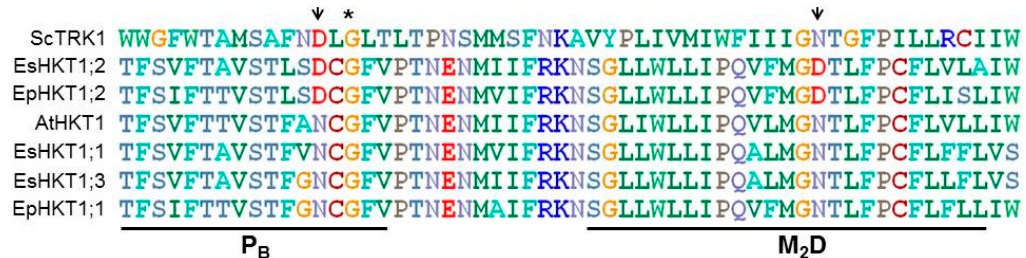
Figure 2. Sequence comparison of HKT homologs from Arabidopsis, E. salsuginea and E. parvula . Amino acid sequences in the second pore loop region (PB) and the adjacent transmembrane domain (M2B) are aligned by clustalw (http://www.ebi.ac.uk/Tools/msa/clustalw2/). The conserved Gly residues in the PB region [49] are indicated by asterisks. The Asp residues specific for EsHKT1;2 (D207) and EpHKT1;2 (D205) are indicated by arrows.